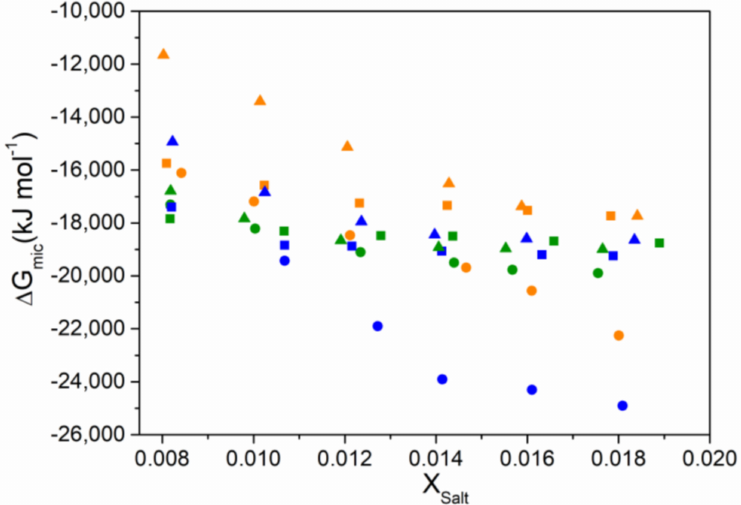
Figure 4. Gibbs free energy of micellization for systems with Pluronic L64 + water + sodium sulfate at pH ( • ) 5.0, ( • ) 7.5, and ( • ) 10.0; Pluronic L64 + water + sodium citrate at pH ( ■ ) 5.0, ( ■ ) 7.5, and ( ■ ) 10.0; Pluronic L64 + water + sodium tartrate at pH ( ▲ ) 5.0, ( ▲ ) 7.5, and ( ▲ )